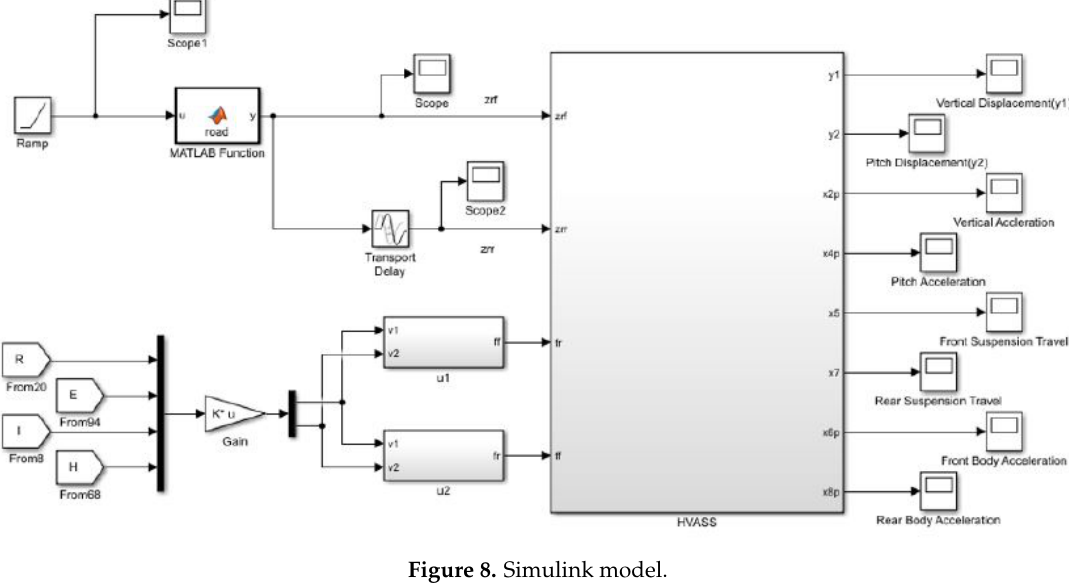
Figure 8. Simulink model.